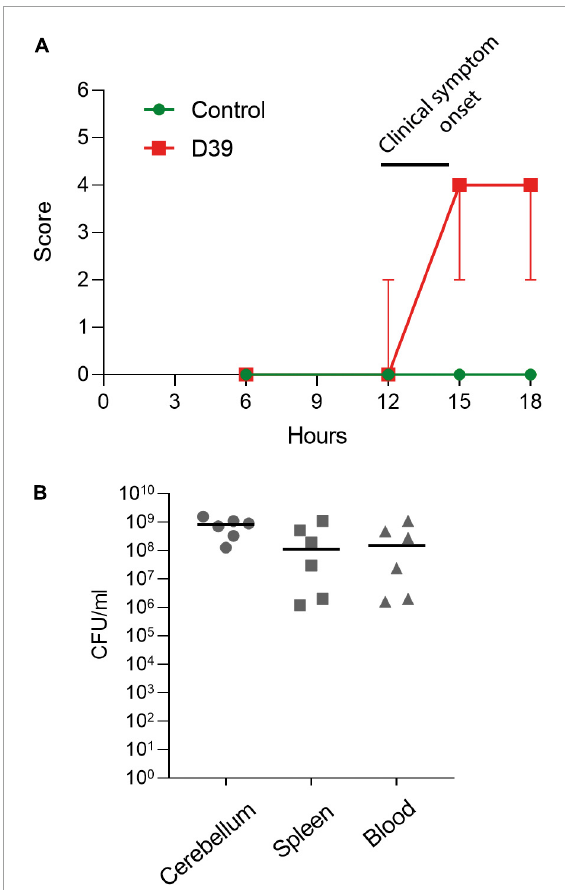
FIGURE1 Characterization of the subarachnoid injection mouse meningitis model. (A) Clinical score of the animals (see section “2. Materials and methods”). Values represent median ± 95% CI. (B) Determination of the colony-forming unit numbers of S. pneumoniae samples from the cerebellum, spleen, and blood of D39-infected mice. Each animal is indicated as a separate symbol in the scatter plot. For mock-infected animals (control), n = 4 animals, for D39-infected mice (D39), n = 6.